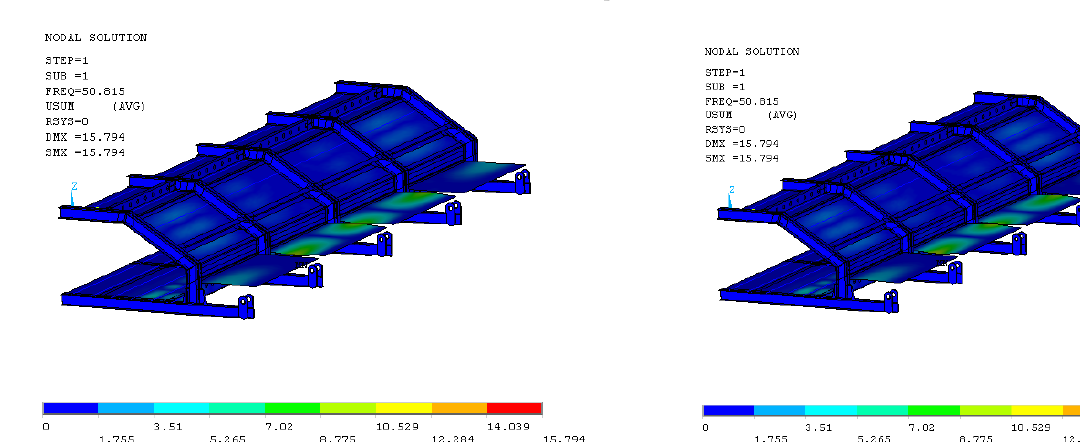
Table 10: Natural frequencies of the roof module.